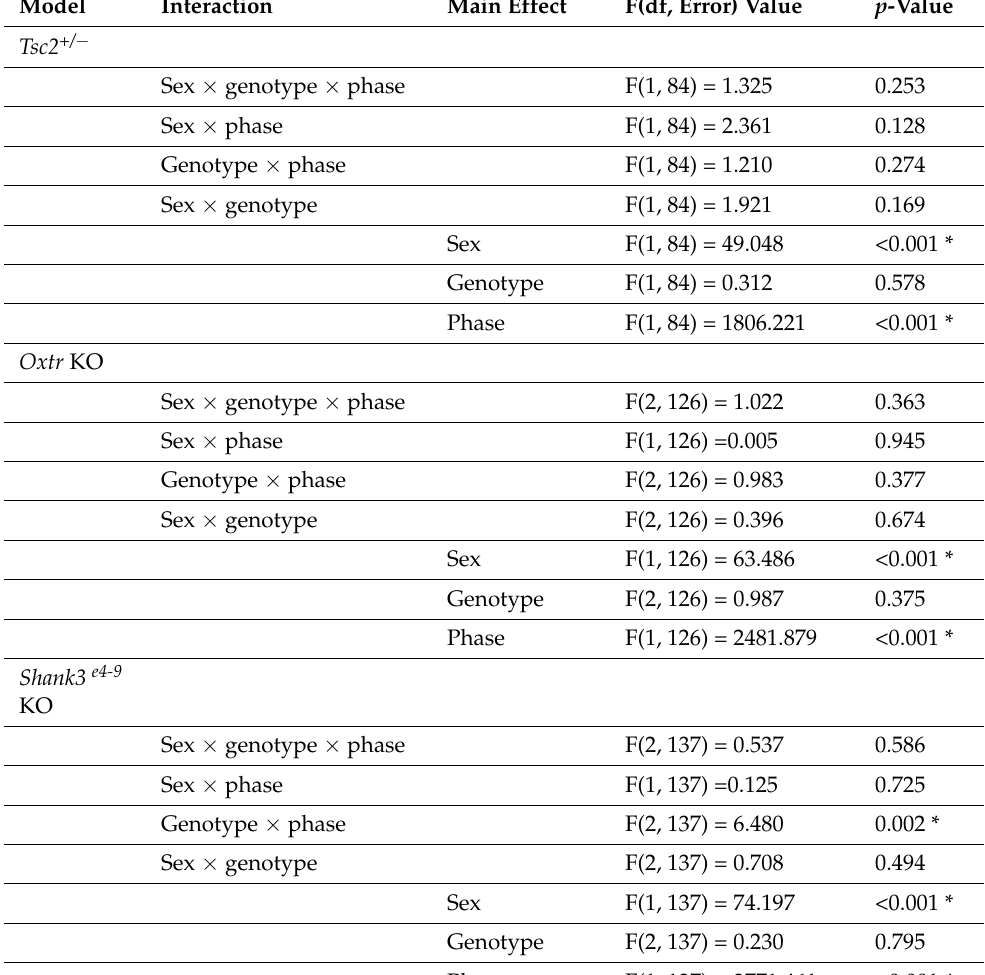
Table 1. Results of repeated measures ANOVA with corresponding F-values and p